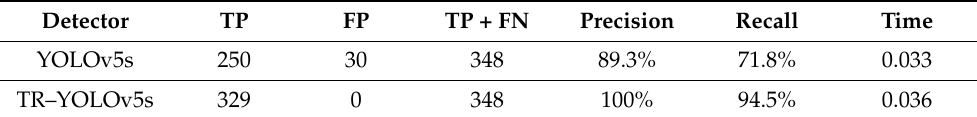
Table 5. The comparison of precision and recall between YOLOv5s and TR–YOLOv5s.